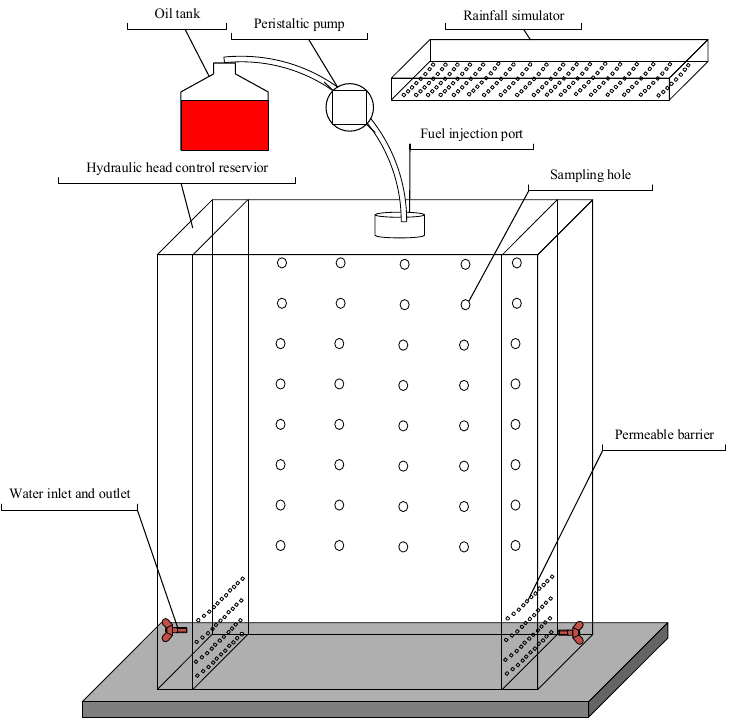
Figure 1. Schematic representation of the flow tank and rainfall simulator.